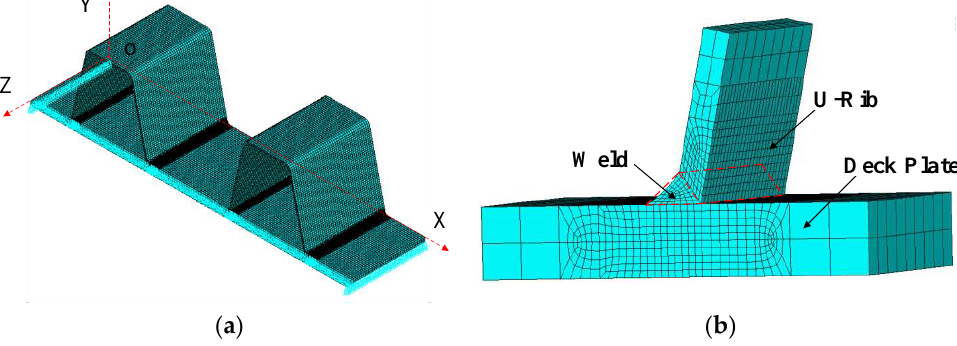
Figure 6. Finite element model (FEM) of the welded joints in the OSD: ( a ) displacement boundary; ( b ) mesh of FEM model.